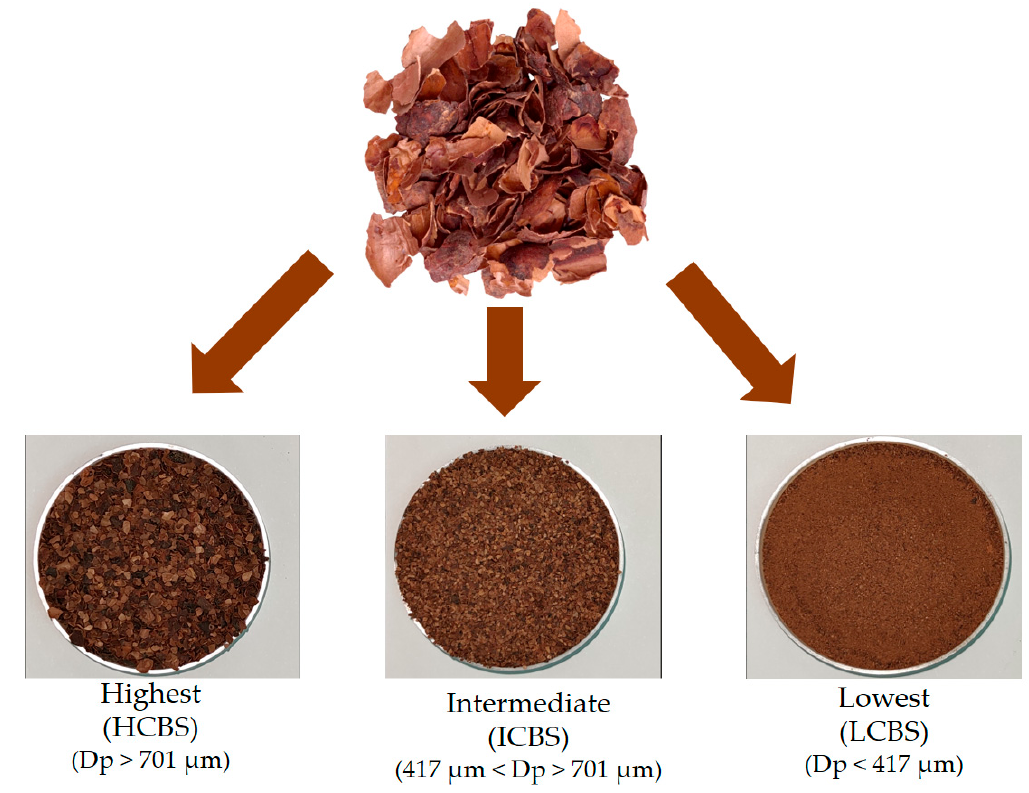
Figure 1. Cocoa bean shell flours with different particle sizes.